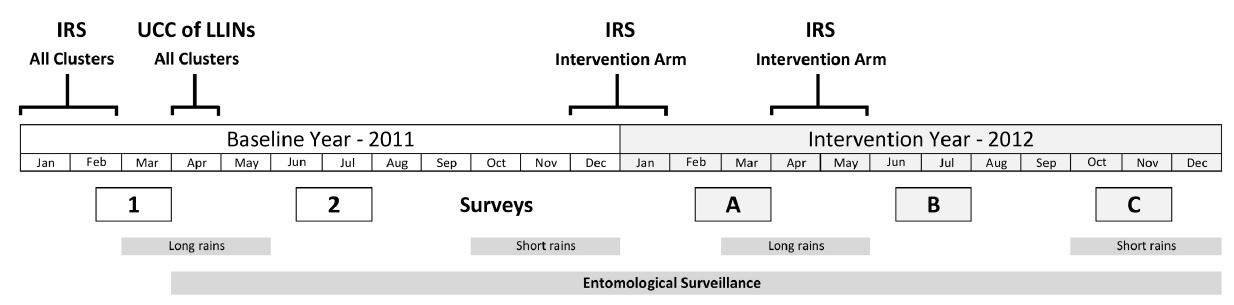
Figure 1. Study timetable. Surveys 1 and 2 are baseline surveys. Surveys A, B, and C are post-intervention.